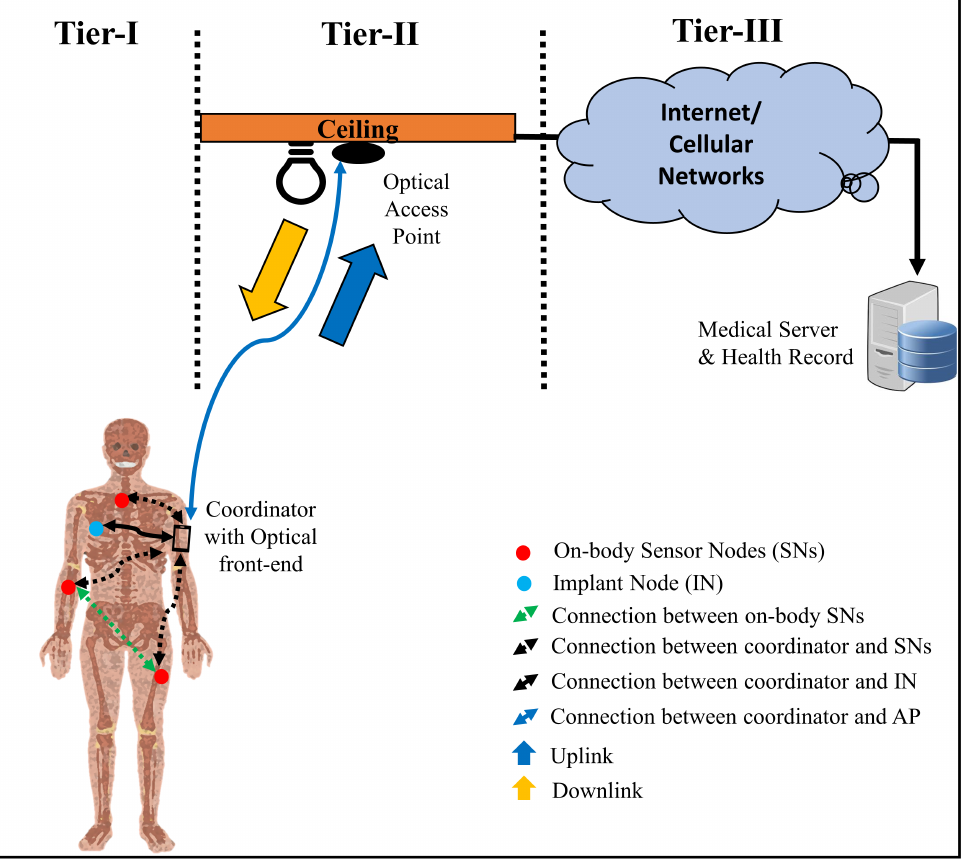
Figure 1. Indoor OBAN communication